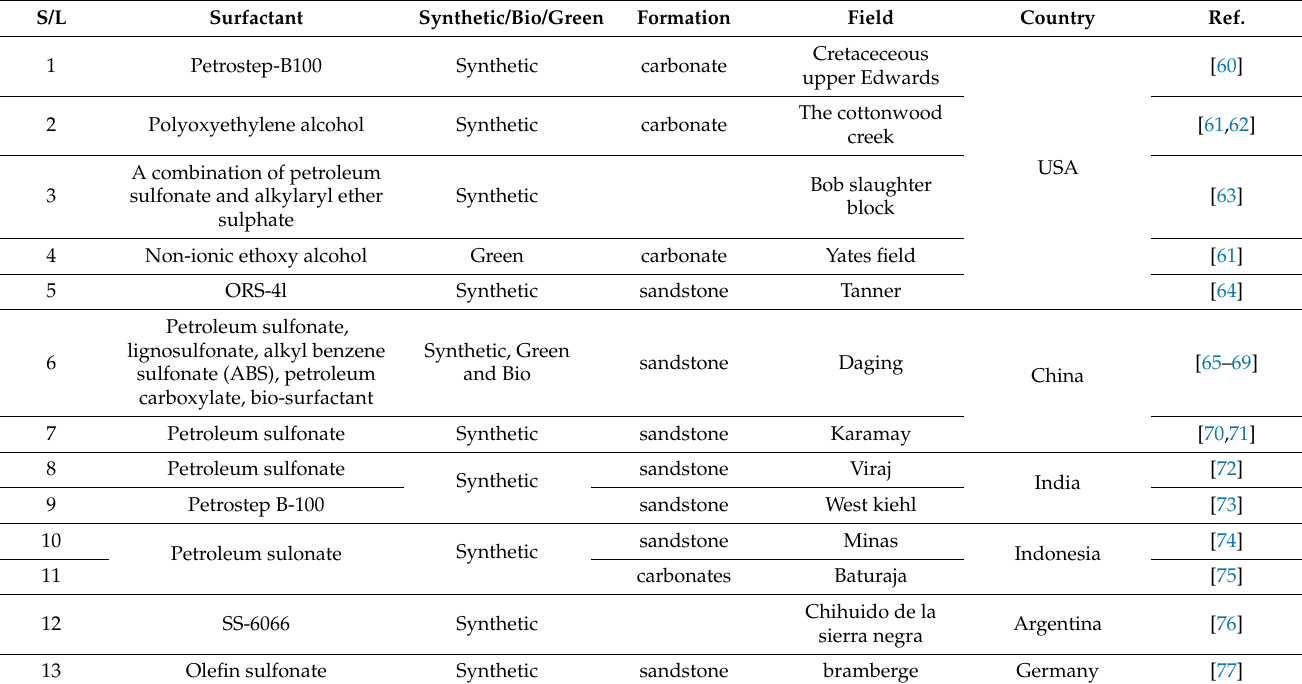
Table A1. Field Application of